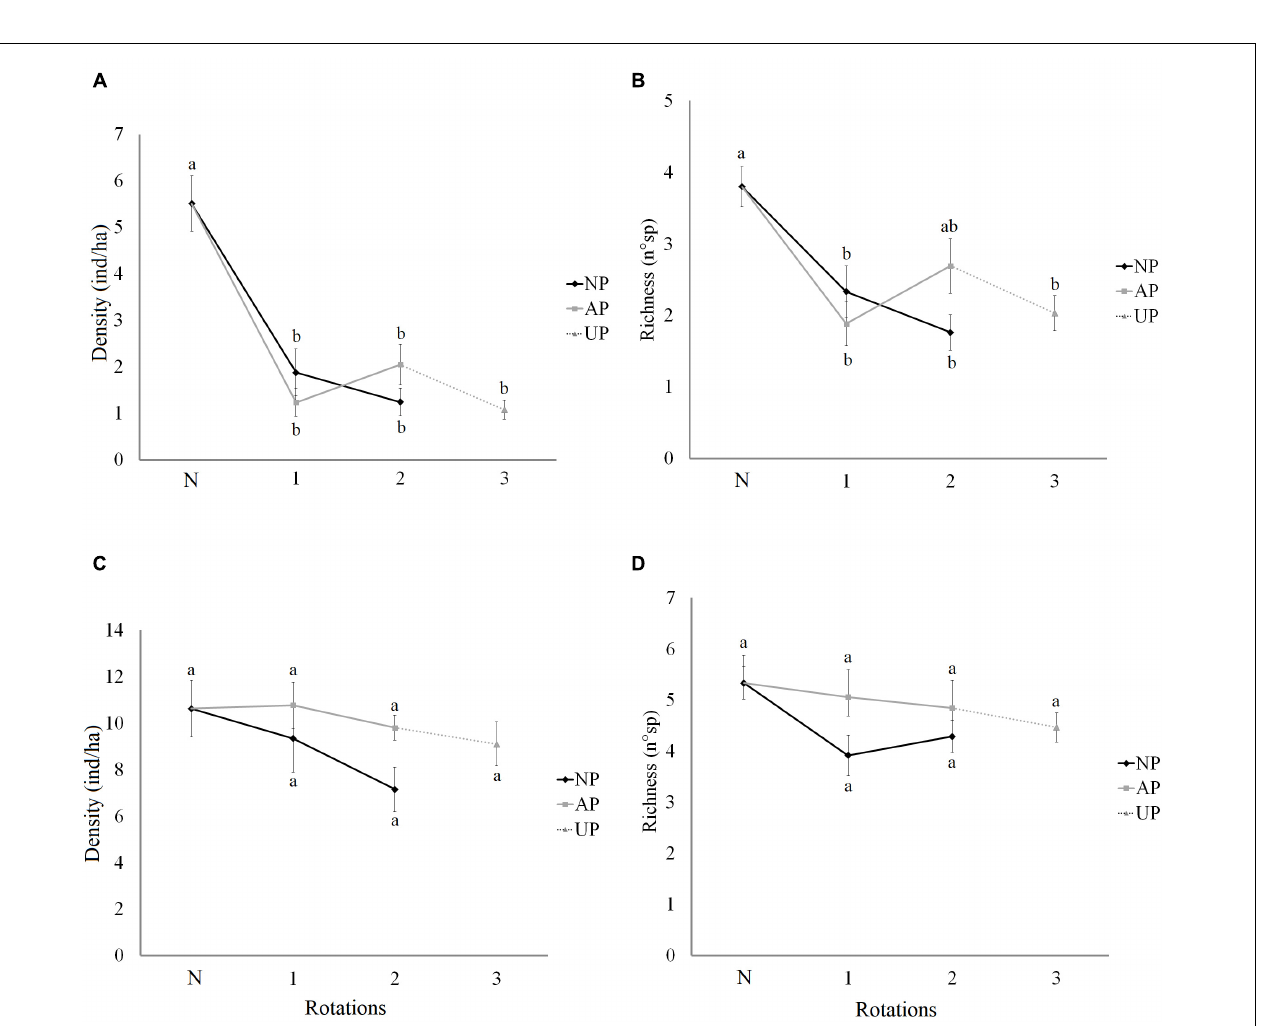
Landscape context